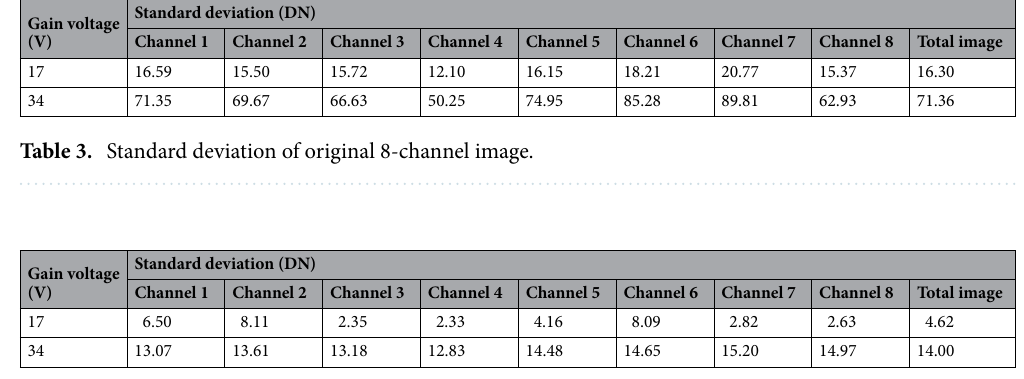
Table 4. Standard deviation of 8-channel image after comprehensive correction.